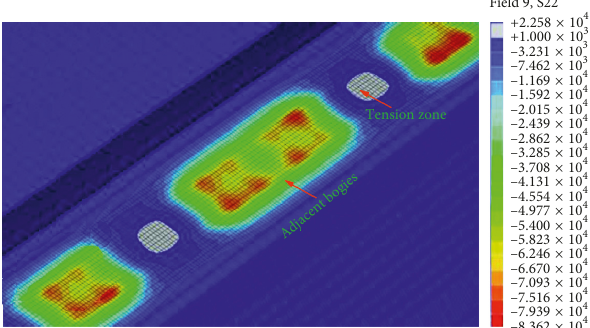
Figure 16: Dynamic stress contour at the subgrade surface con- sidering the irregularity difference of the left and right rails.